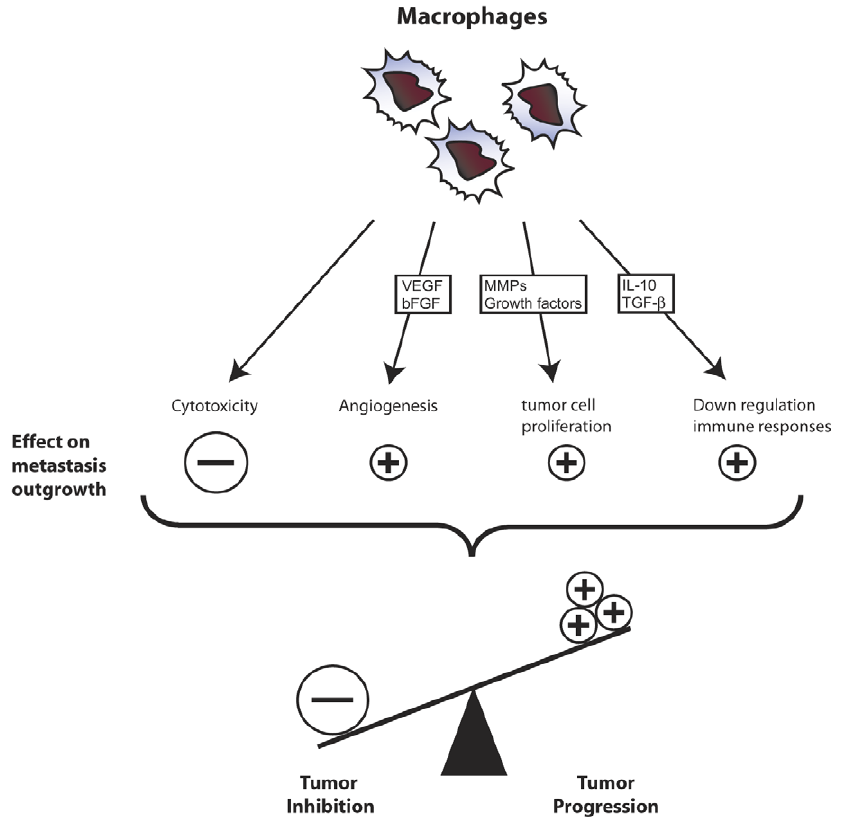
Fig. 4. Net effect of macrophages on tumor outgrowth. Macrophages contribute to tumor growth and differentiation into a malignant pheno- type by production of growth factors and MMPs, induction of angiogenesis and downregulation of immune responses. However, depletion of macrophages led to poorer survival compared to control animals, illustrating the importance of macrophage mediated tumor cell killing. Thus, the anti-tumor properties of macrophages are prevalent over the tumor promoting characteristics, resulting in an overall beneficial effect of macrophages on